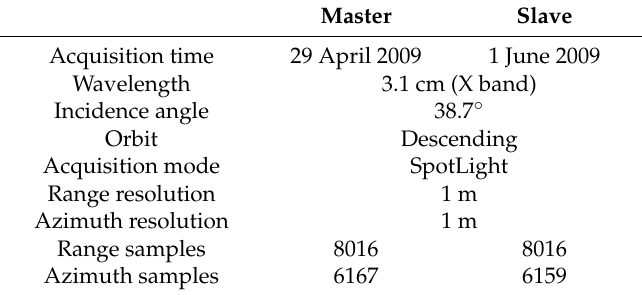
Table 1. Basic information of TerraSAR-X data of the Hong Kong